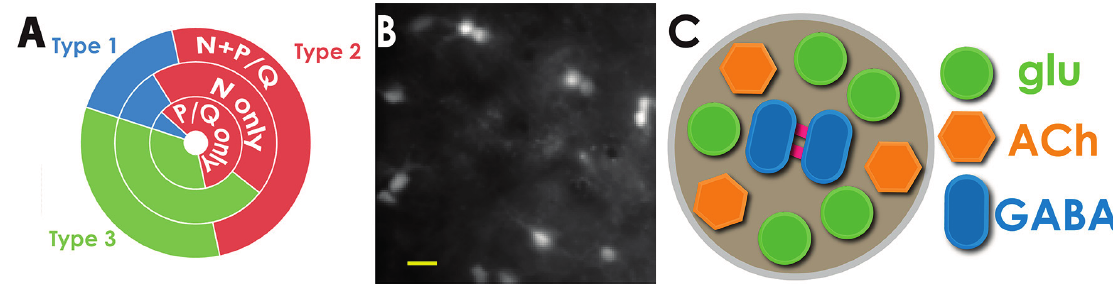
Figure 2. Calcium channel PPN cell types, electrical coupling, and ensembles. ( A ) Pie chart showing the distribution of N + P/Q, N-only, and P/Q-only PPN cells according to electrophysiological type. Since type I PPN cells are non-cholinergic, type II are 2/3 cholinergic, and type III cells 1/3 cholinergic, it suggests that PPN neurons with one or both calcium channel types are represented in all transmitter types, cholinergic, glutamatergic, and GABAergic. That is, there are groups of PPN neurons that are N + P/Q that manifest all three transmitter types, as do groups of N-only and P/Q-only cells; ( B ) View of background activity in a PPN slice after loading with Fura2. Note that the majority of cells showing high levels of calcium in the absence of stimulation were found in pairs spaced about 100 μ m apart. This suggests the presence of cell ensembles anchored by pairs of electrically coupled cells that are usually GABAergic. Calibration bar 25 μ m; ( C ) Glutamatergic neurons are shown as green circles, cholinergic neurons as orange hexagons, and GABAergic cells as blue ovals, some being electrically coupled (red bars). Groups of cells with a 5:3:2 ratio would all need to express the same channel subtype. Ensembles expressing only N-type channels would fire during REM sleep (REM-on), those expressing only P/Q-type channels would fire during waking (Wake-on), and those expressing both would fire during both states (Wake/REM-on)